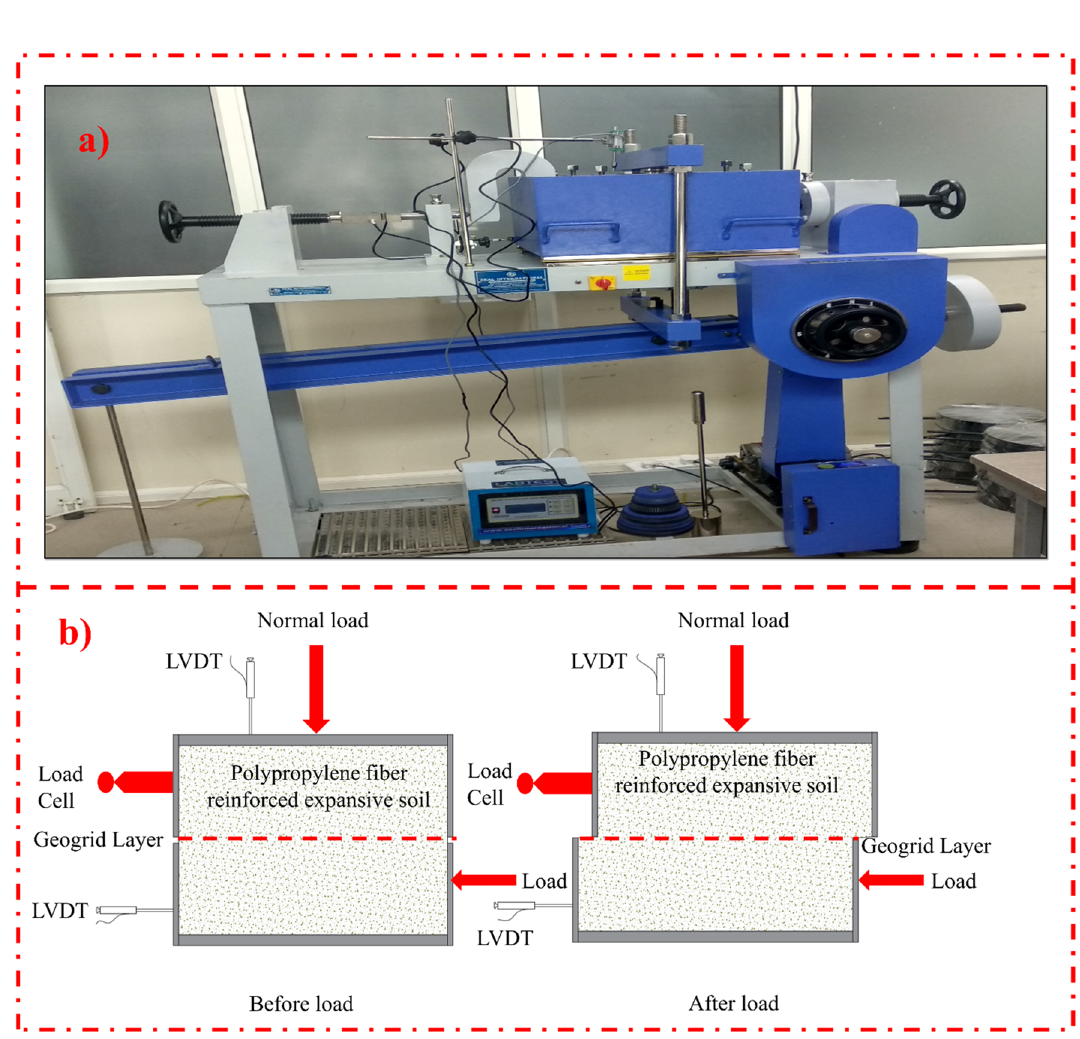
Figure 2. Experimental Setup for the large direct shear test ( a ) equipment used ( b ) shear box